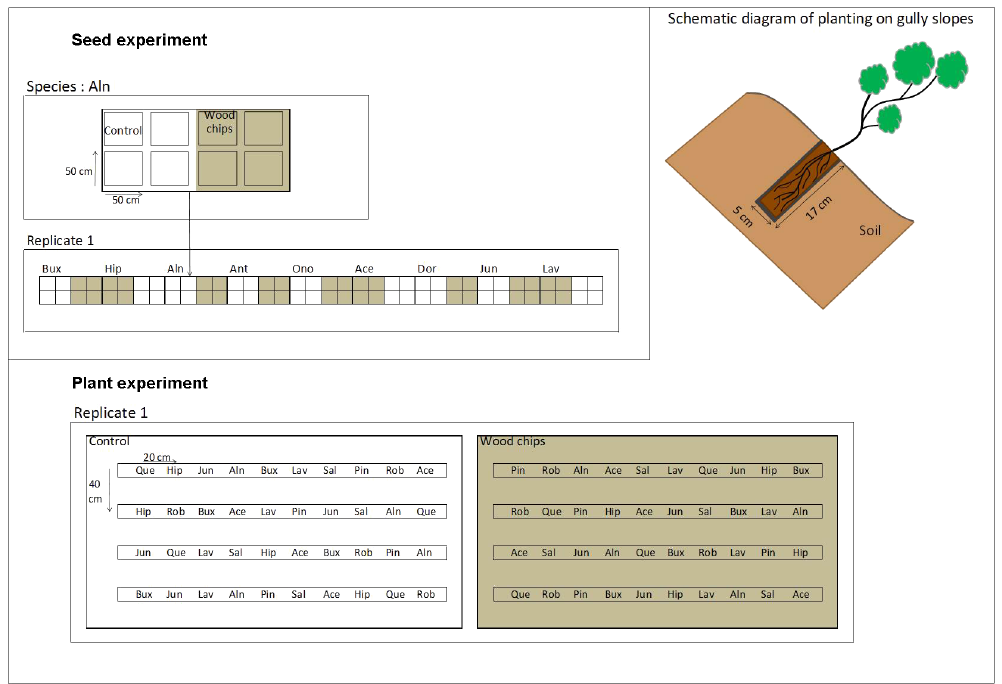
Figure 2. Experimental design of the two experiments (see species abbreviations in Table 1).